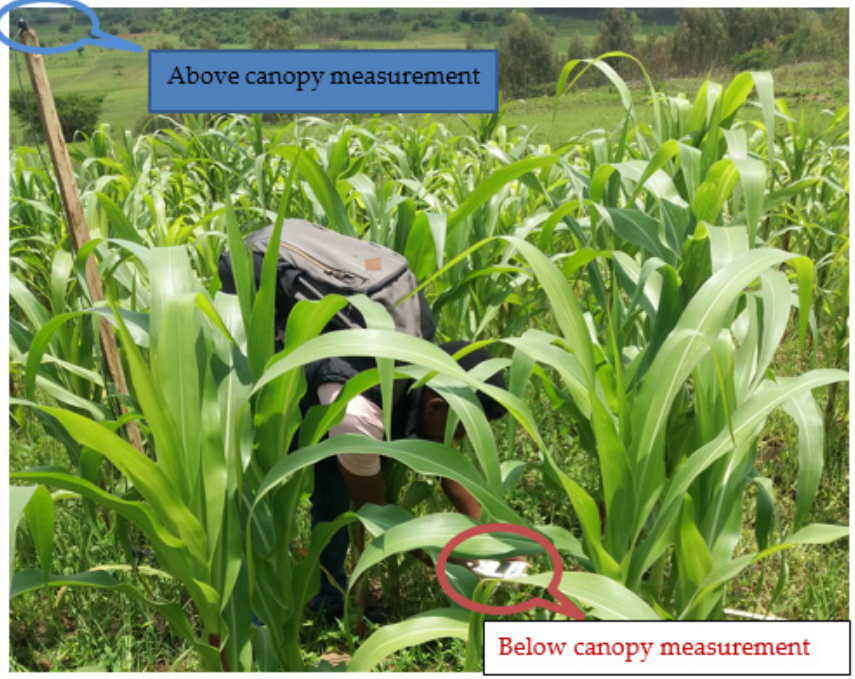
Figure 4. LAI measurement by LAI2100 Plant Canopy Analyzer. We collected LAI samples as the vegetation descriptor of WCM for soil water content retrieval at nine sampling points, measured on teff, maize, and millet in both watersheds. A total of 63 LAI data were recorded from both watersheds in the early mornings under diffuse light conditions, following Heuvelink’s recommendation [61,62] to avoid direct sunlight. The satellite synchronized data collection was carried out from 9:00 am to 11:30